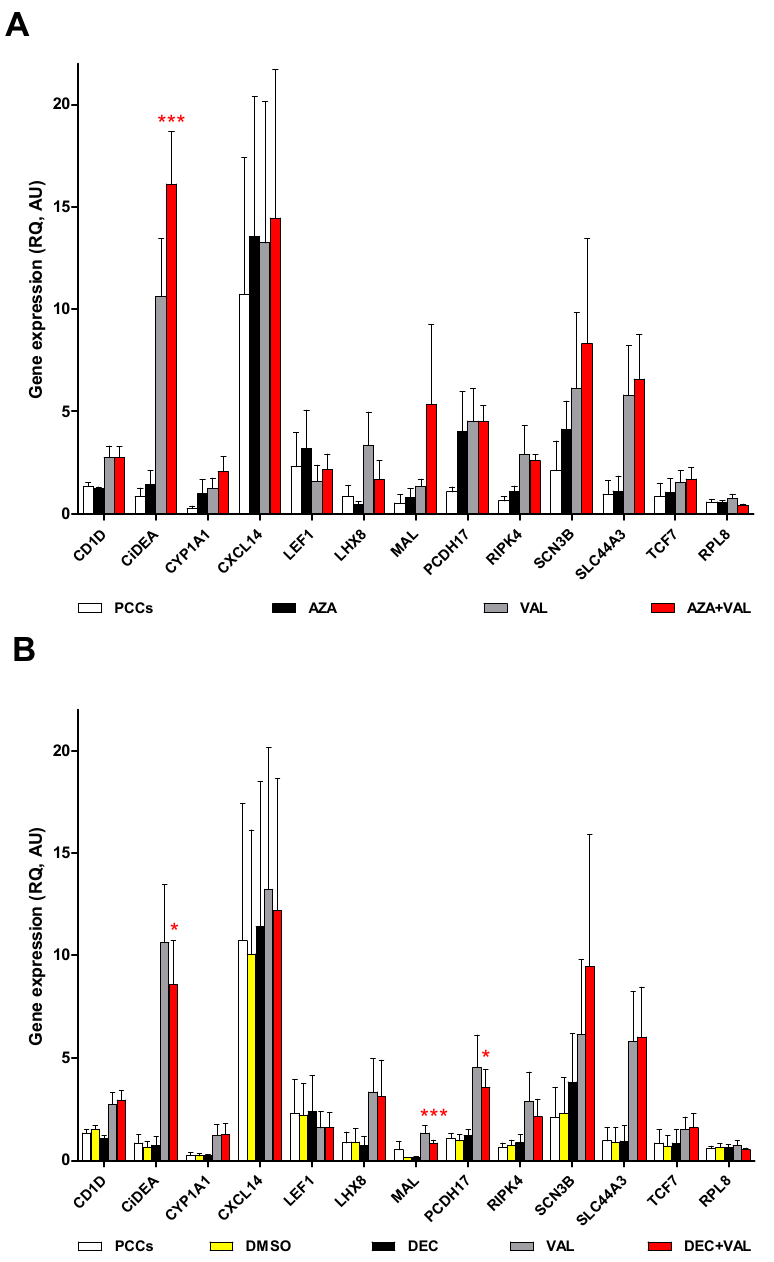
Figure 4. Effect of the treatment with AZA or DEC in combination with VAL on the mRNA expression of 12 candidate TSGs in four PCCs. ( A ) AZA, ( B ) DEC. The expression levels of the target mRNAs (relative expression values, RQ), evaluated by qPCR and normalized to GOLGA1 and CCZ1 , are expressed in arbitrary units (AU), as the mean ± SEM. RPL8 , the negative control gene, was not affected by the treatment, as expected. Statistical analysis: ANOVA + Bonferroni post hoc test. *: p < 0.05; ***: p < 0.001. The statistical significance between PCCs vs. AZA + VAL and DMSO vs. DEC + VAL only is shown.